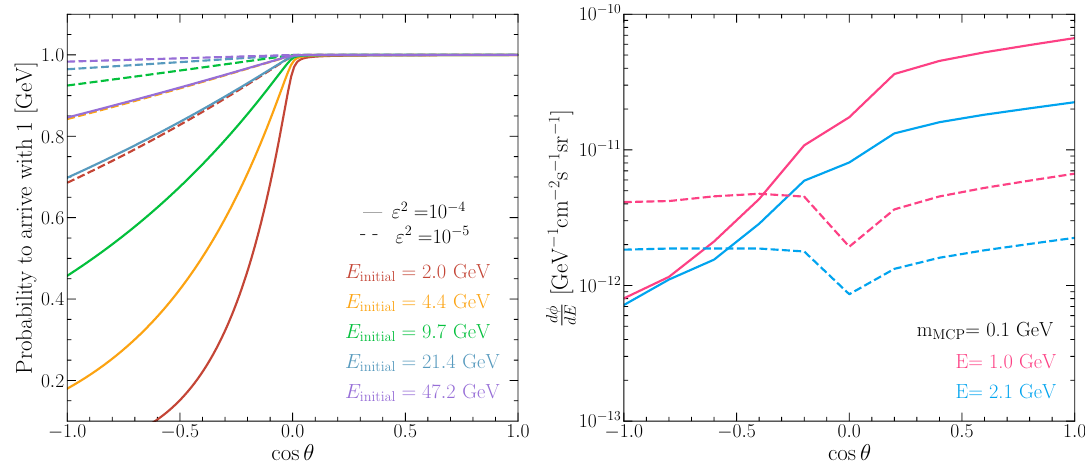
Figure 4 . Survival probability of MCPs and expected angular distribution. Left: probability that an MCP with initial energies as indicated by the labels arrives at the detector with a total energy of 1 GeV as a function of the cosine of the zenith angle. Solid lines are shown for ε = 10 − 4 and dashed lines for ε = 10 − 5 . Right: flux at detector as a function of cosine of the zenith angle for a 100 MeV mass MCP, arriving with an energy of 1 . 0 GeV (pink) and 2 . 1 GeV (blue). Solid and dashed lines corresponds to the same values of ε as in the left